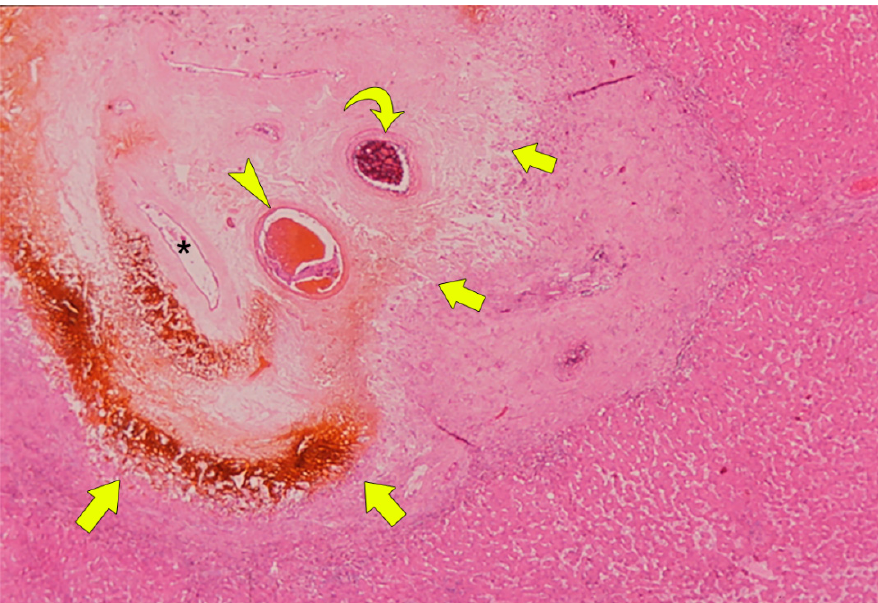
Figure 8. Photomicrograph of BDN. Coagulation necrosis is observed within the portal tract (arrows). The lumen of the necrotic bile duct is open (*). Thrombosis is observed in the portal venous branch (arrowhead). Embolic material is observed in the hepatic arterial branch (curved arrow). (H&E stain; original magnification, ×40.).